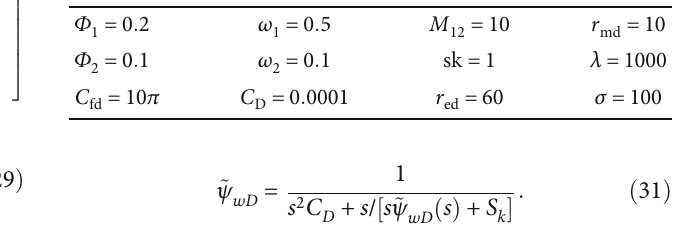
Figure 10: Flow stage divided for rectangle coal reservoirs. Table 2: The basic data of the